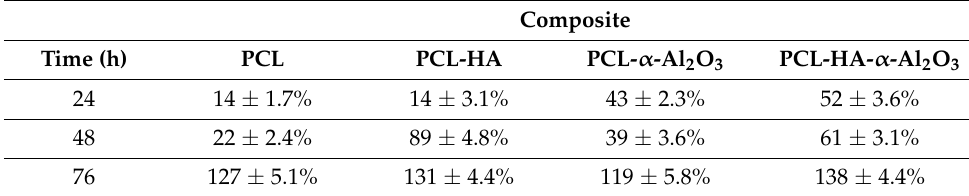
Table 1. Percentage of Cell viability test